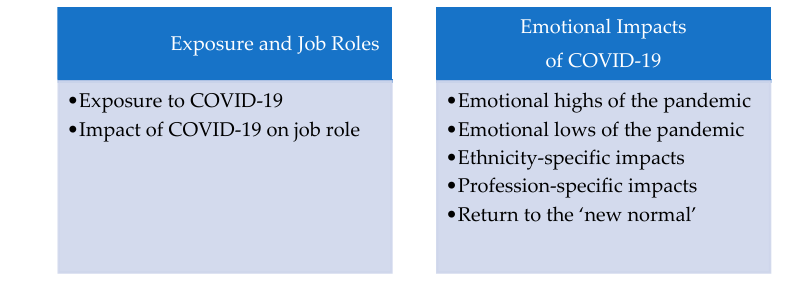
Figure 1. Themes and subthemes.